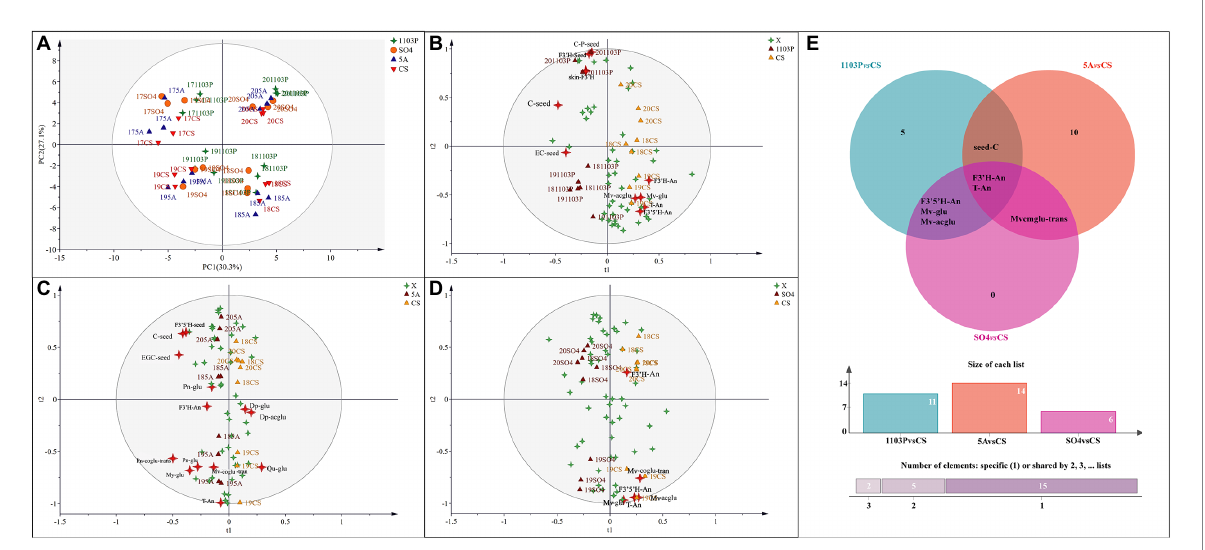
FIGURE 2 Principal component analysis (PCA) based on flavonoid compound concentrations of grapes in four vintages (2017–2020) (A) ; Orthogonal partial least squares discriminant analysis (OPLS-DA) based on flavonoid compound concentrations of grapes in three vintages (2018–2020) (B–D) ; Venn diagram based on differential compounds (VIP > 1) in grapes (E) . The abbreviated names of the substances in the figure are shown in Supplementary Table S6.